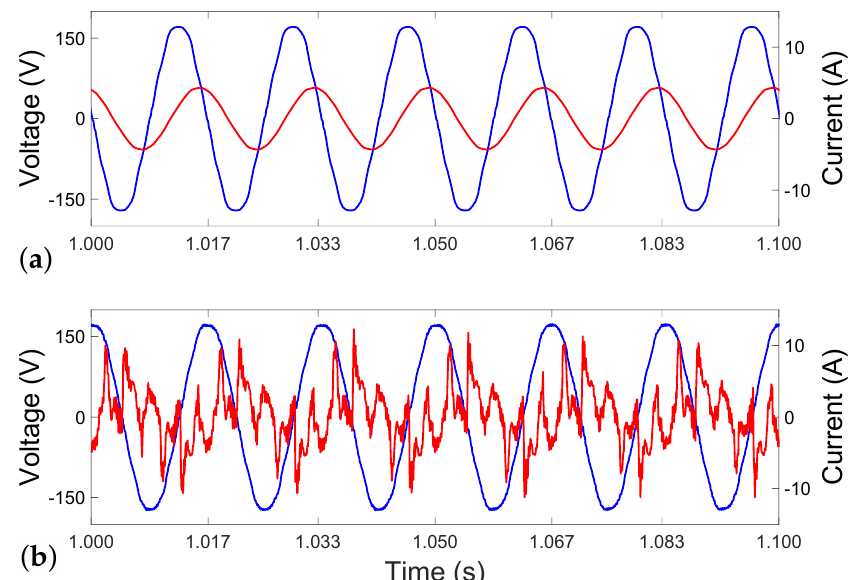
Figure 1. Voltage (blue) and current (red) wave forms when the inverter ( a ) is off and ( b ) supplies 1.125 kW of active power to the load and grid, illustrating significant harmonic distortion on inverter